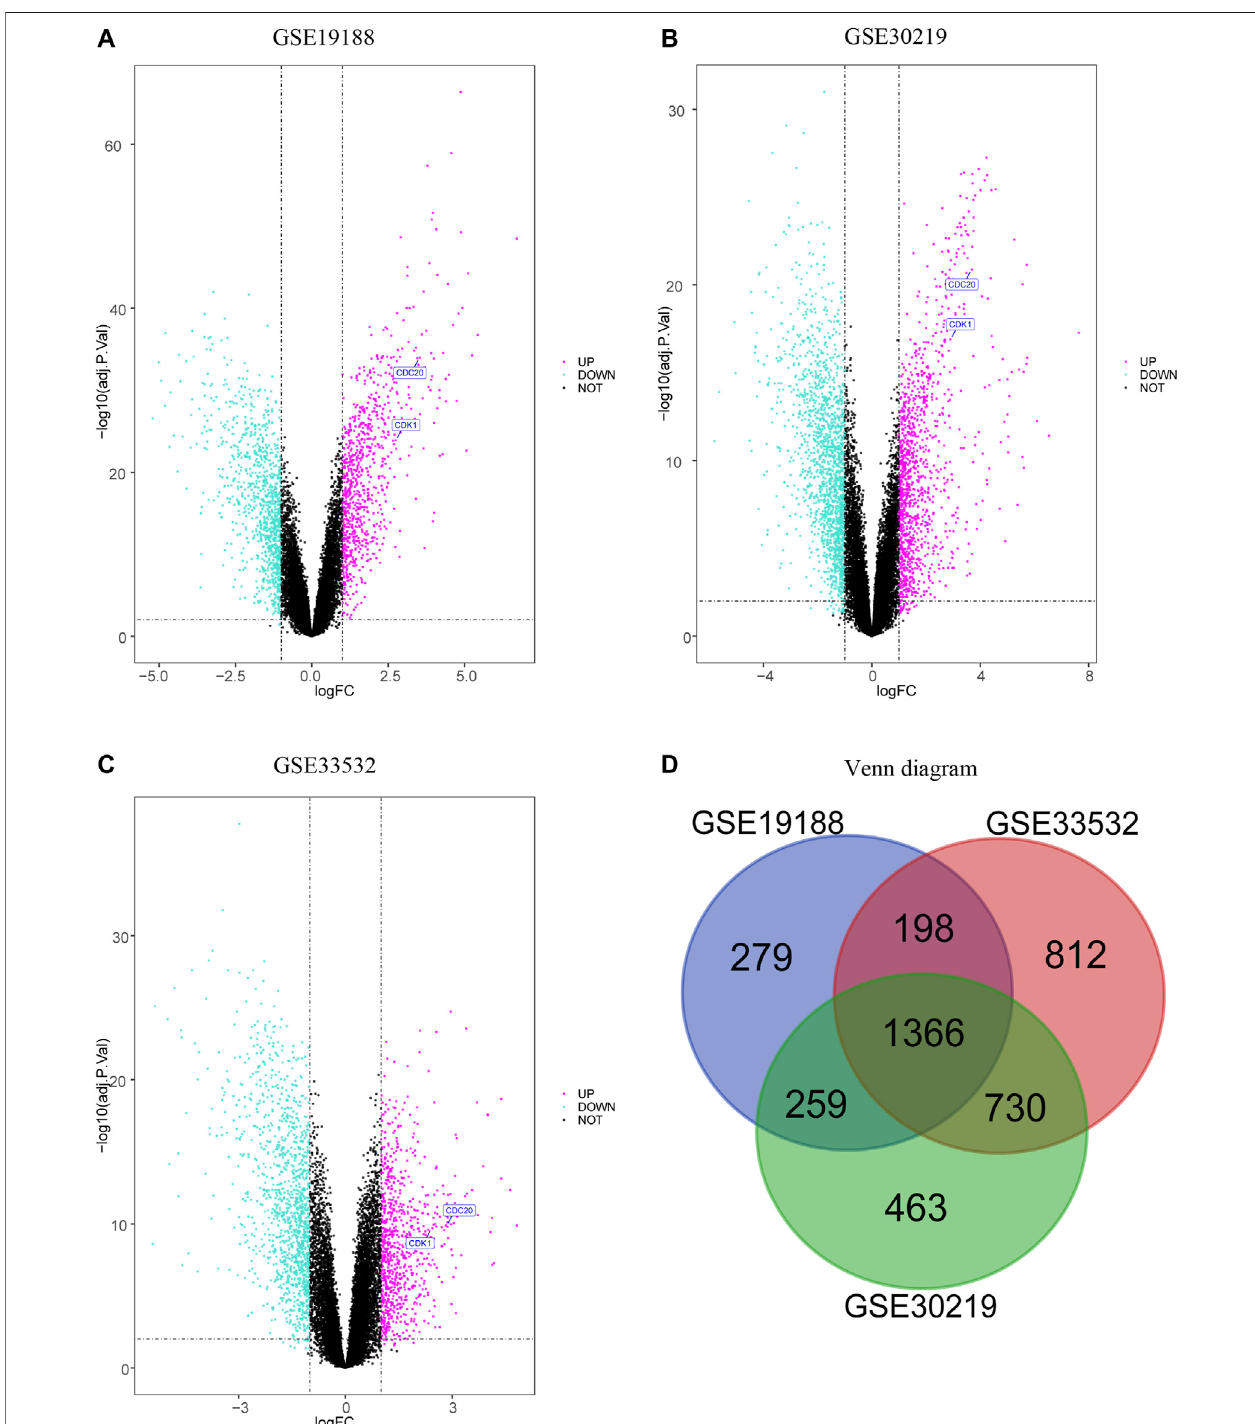
FIGURE 1 | Volcano plot and Venn diagram of three expression pro fi les. The selection procession of downregulated and upregulated genes in GSE19188 (A) , GSE30219 (B) and GSE33532 (C) with p -value < 0.05 and |logFC| > 1, and upregulated genes are marked in red, and downregulated genes are marked in green. The three datasets display an overlap of 1366 DEG (D)